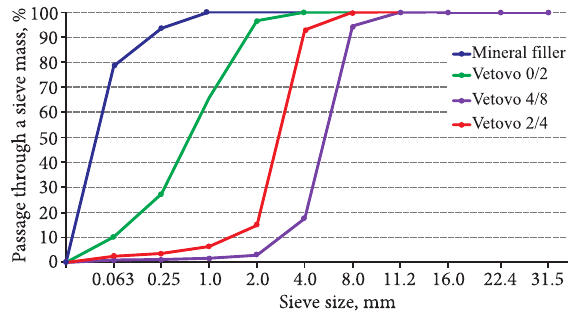
Fig. 1. Gradation of stone fractions and filler of asphalt mixture